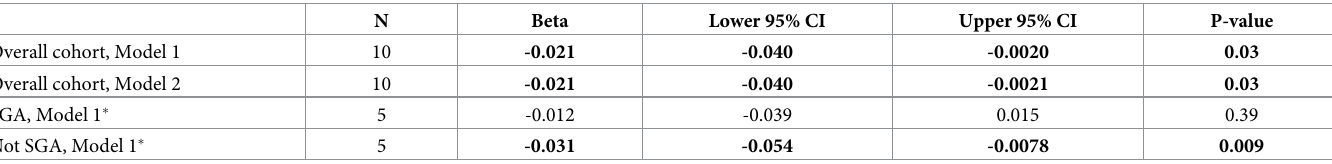
Table 3. Estimated decline in relative telomere length (units per postmenstrual week). N Beta Lower 95% CI Upper 95% CI P-value Overall cohort, Model 1 10 -0.021 -0.040 -0.0020 0.03 Overall cohort, Model 2 10 -0.021 -0.040 -0.0021 0.03 SGA, Model 1 � 5 -0.012 -0.039 0.015 0.39 Not SGA, Model 1 � 5 -0.031 -0.054 -0.0078 0.009 Model 1 adjusted for gestational age at birth. Model 2 also adjusted for the Score for Neonatal Acute Physiology Perinatal Extension II, a measure of neonatal illness severity [35]. Higher illness severity defined as at or above the median score of 44. Birth weight percentile based on the Olsen reference [42]; small for gestational age (SGA) defined as birth weight < 10 th percentile. Bold face type indicates p < 0.05. � Interaction p = 0.43.